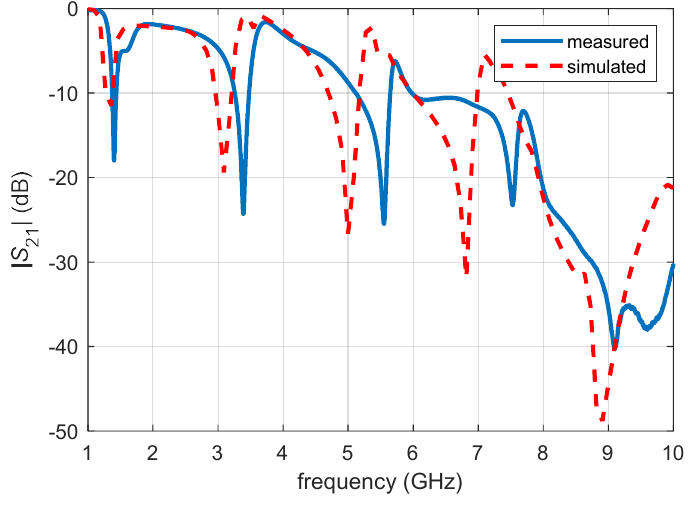
| for the sensor 21